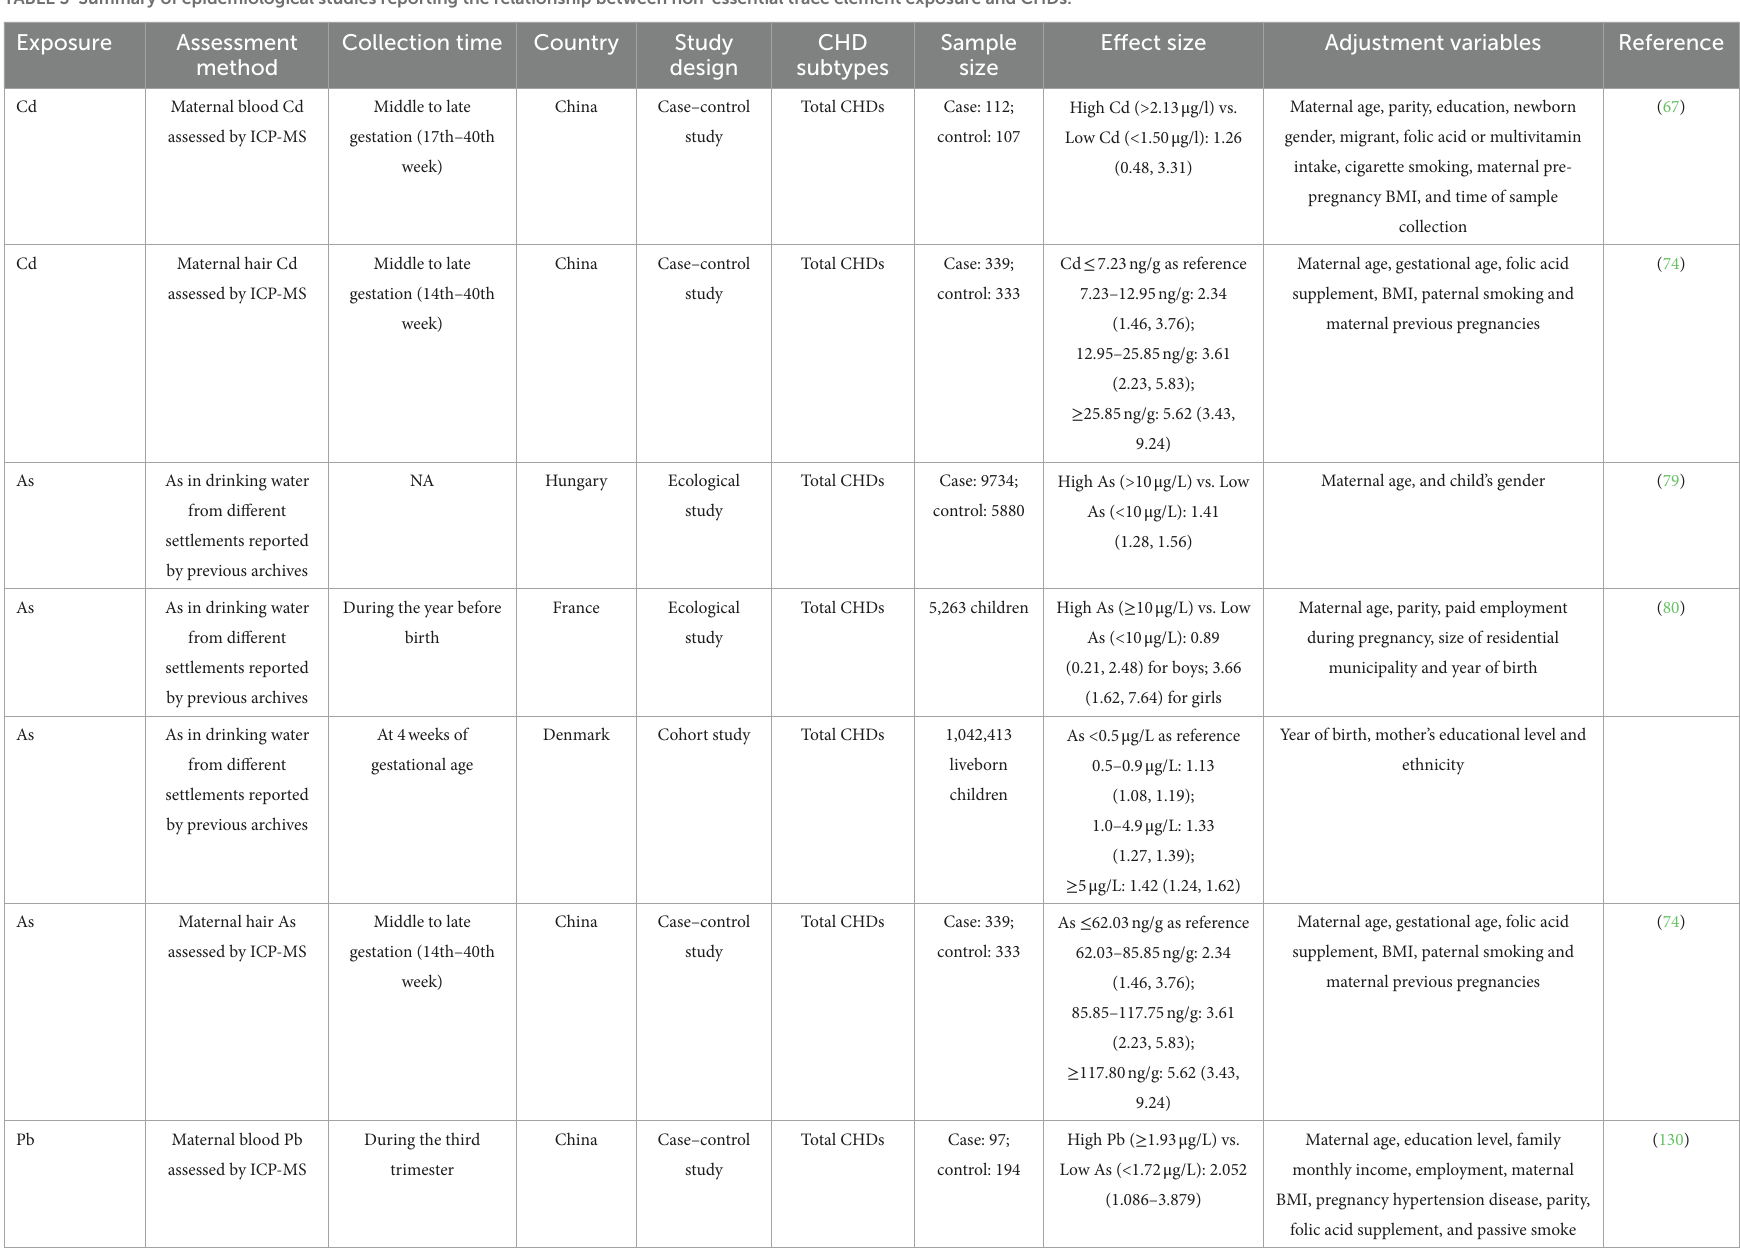
TABLE 3 Summary of epidemiological studies reporting the relationship between non-essential trace element exposure and CHDs.